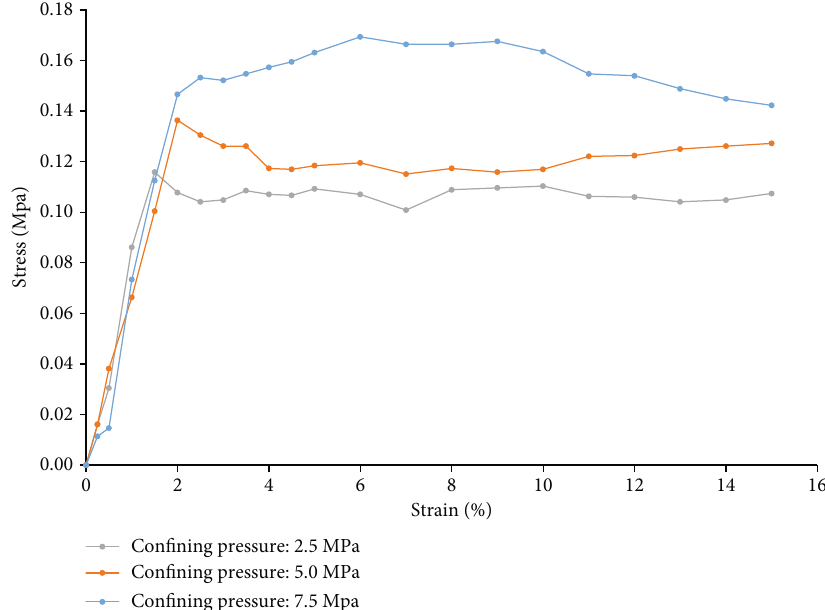
Figure 2: Stress-strain relationship of clayey-silt sediments